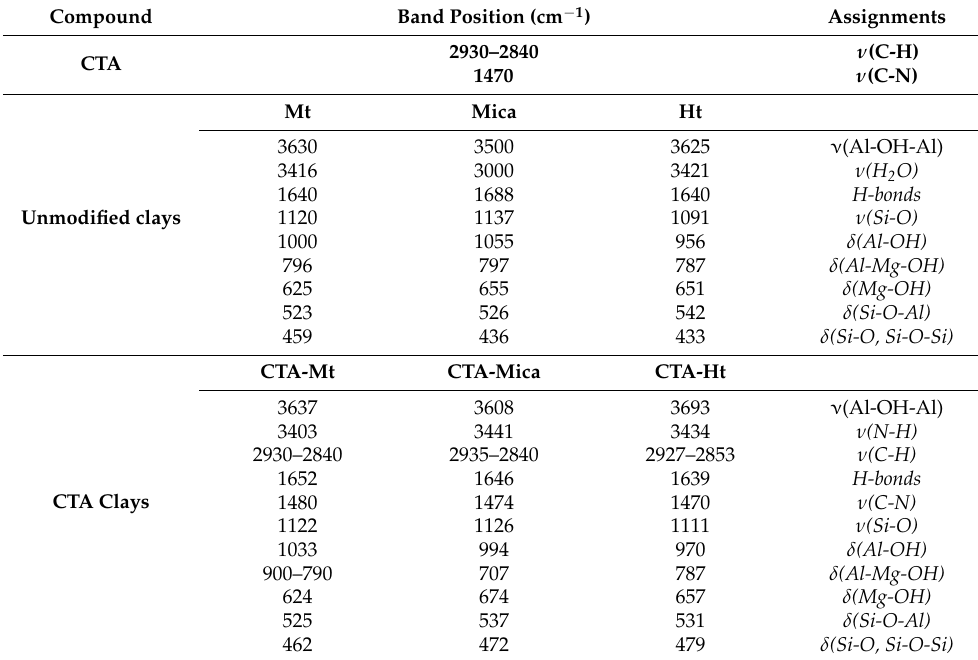
ν = Stretching vibrations; δ = bending vibrations.